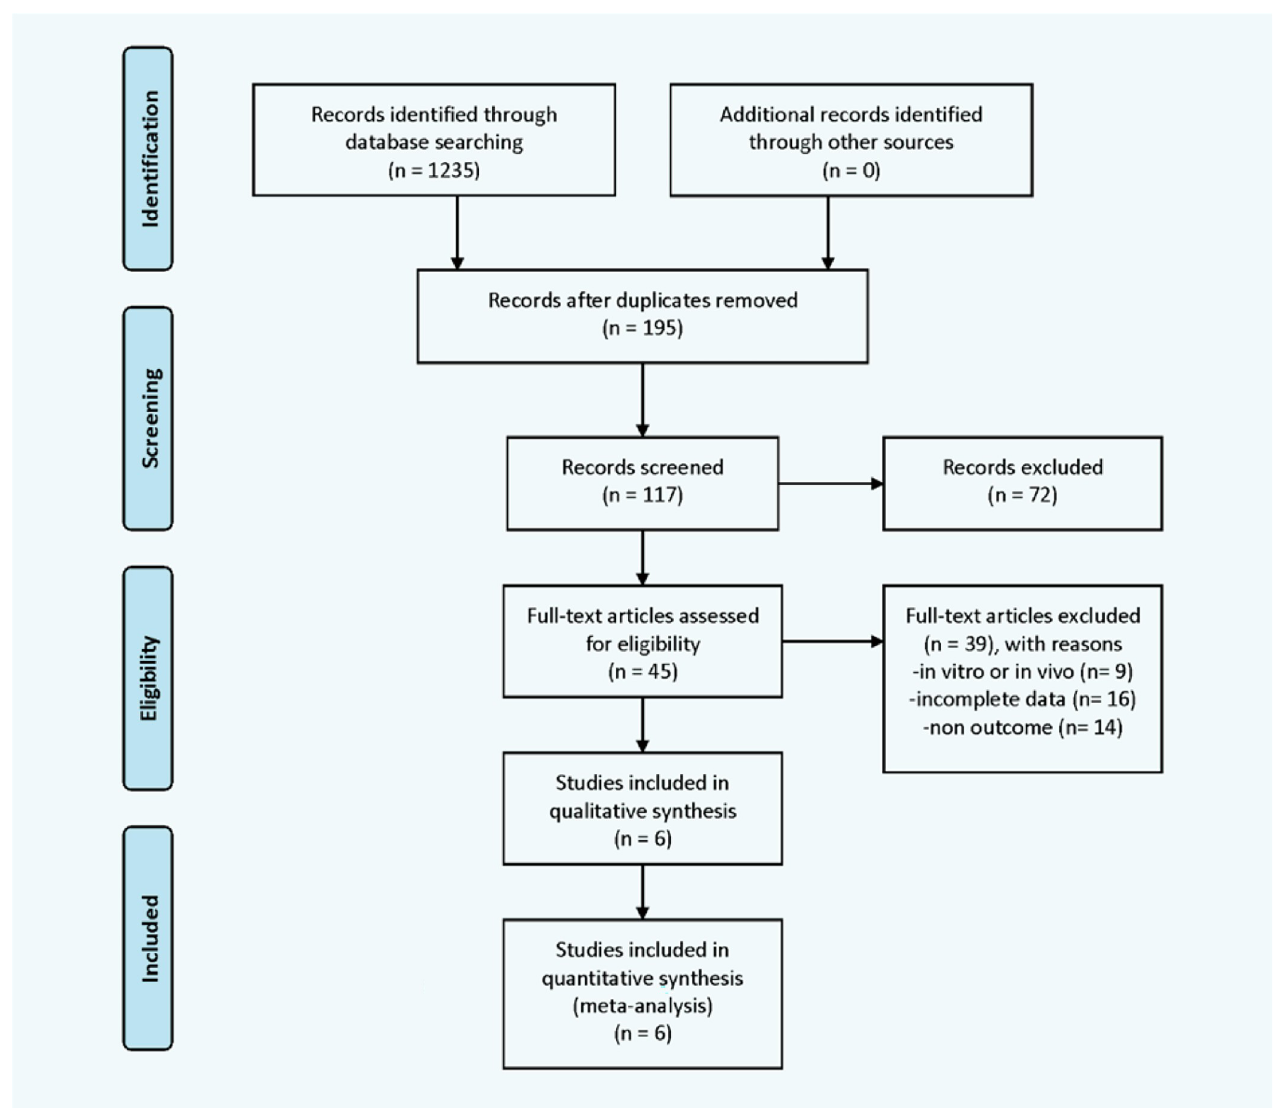
Fig 1. Flow chart showing the process used to select articles for meta-analysis. complete removal of the tumors. Meanwhile, a normal liver tissue pool from 10 healthy liver donors was assigned as the control group [32]. Zhang et al. selected HCC tissues as the study group and nontumorous tissues as the control group [33]. Darweesh et al. selected patients with HCC as the study group and healthy volunteers as the control group. Healthy paticipants were those who had normal liver enzyme levels and functions, negative results on viral hepati- tis screening, and normal abdominal ultrasound scans [38]. Six did not mention blinding in the outcome analysis. Specific grouping information was not clearly described; only one study was evaluated as having a high risk of bias, and the degree of assignment bias was unknown in one study. Three studies did not specify whether testing was performed using blinded princi- ples, and the amount of missing data was not specified in one article. Testing bias was identi- fied in three studies. Some of the included studies did not describe the staging of HCC. The quality assessment results are shown in Fig 2.